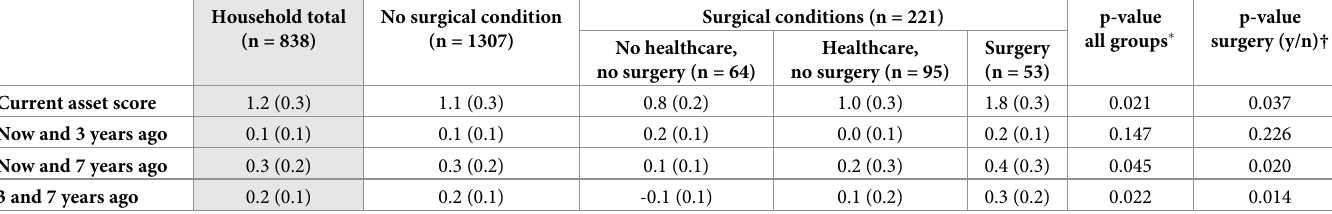
Table 4. Assets owned and poverty trajectory, stratified by level of healthcare received (n = 1503).